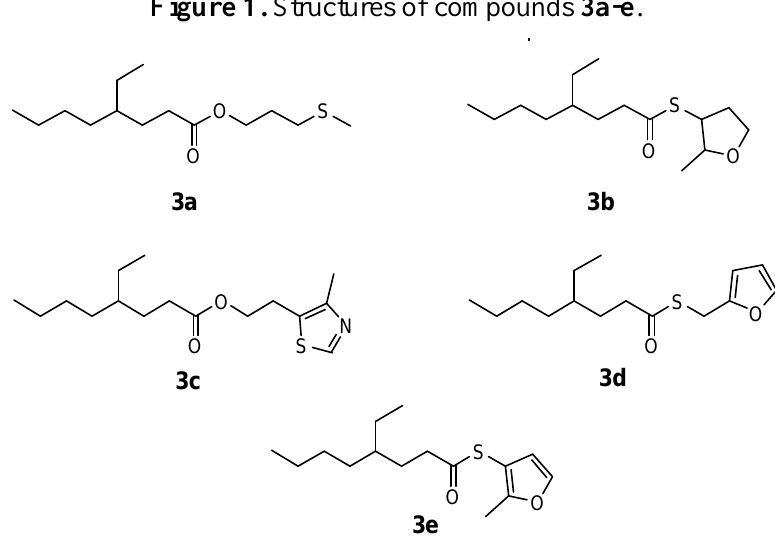
Figure 1. Structures of compounds 3a-e .